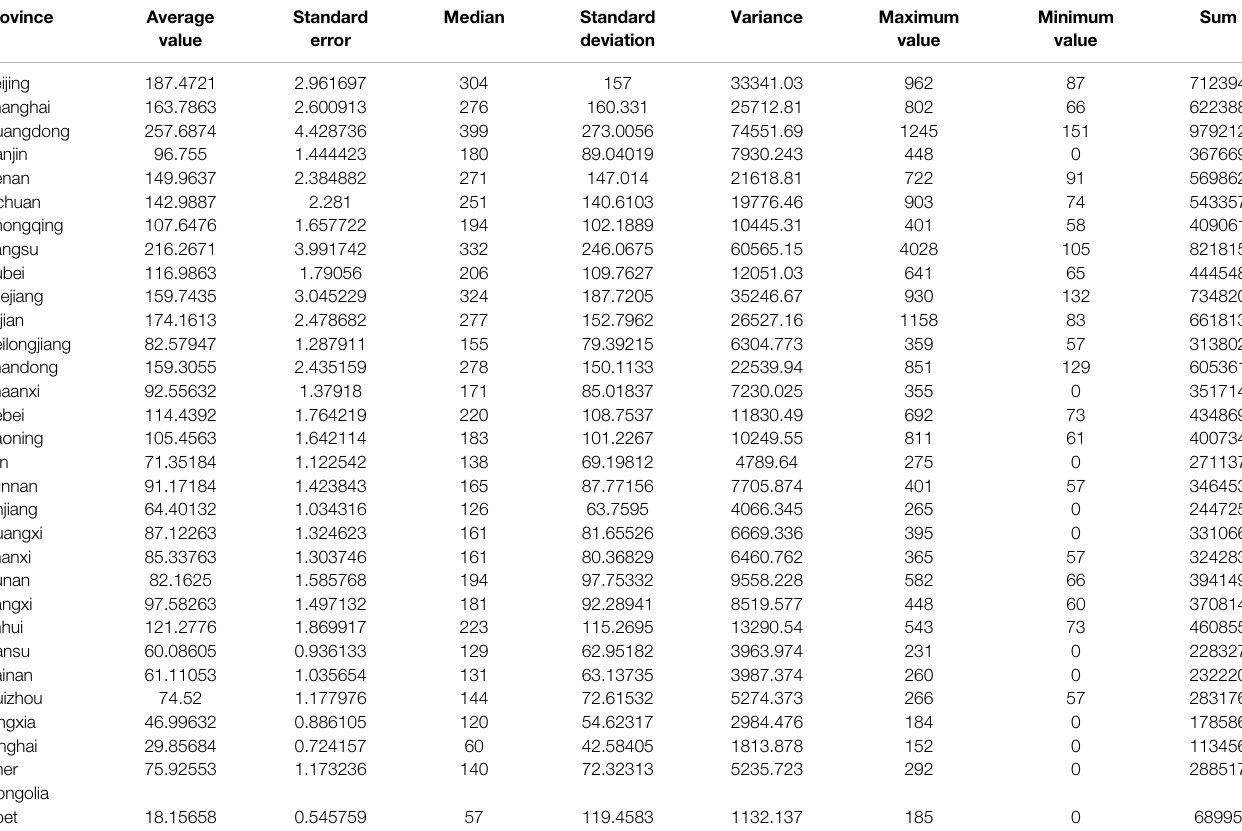
TABLE 1 | Original data from the Baidu search index in various provinces and cities.